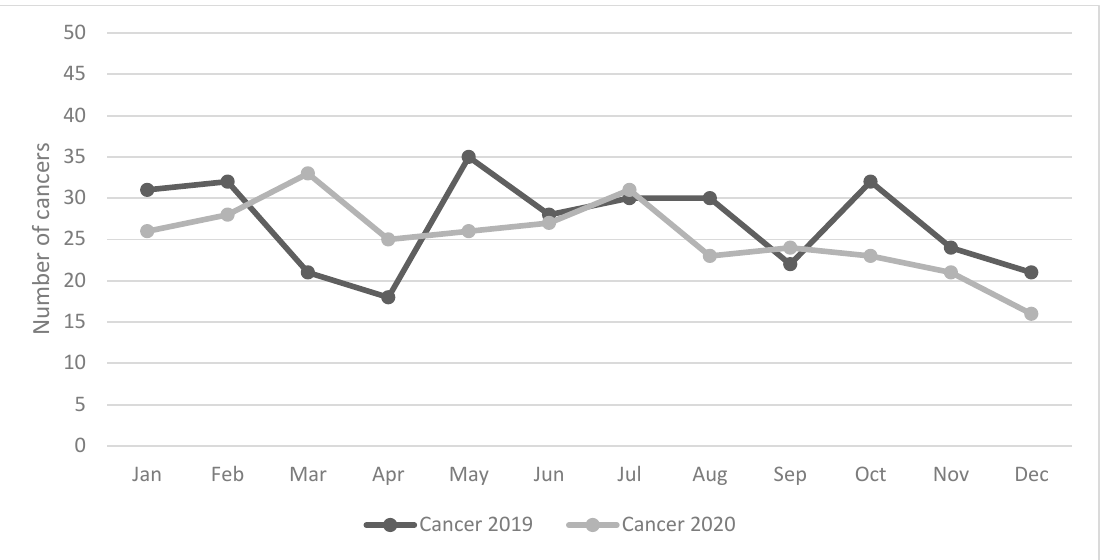
Figure 2. Number of cases of lung cancer by month of diagnosis. Years: 2019 and 2020.